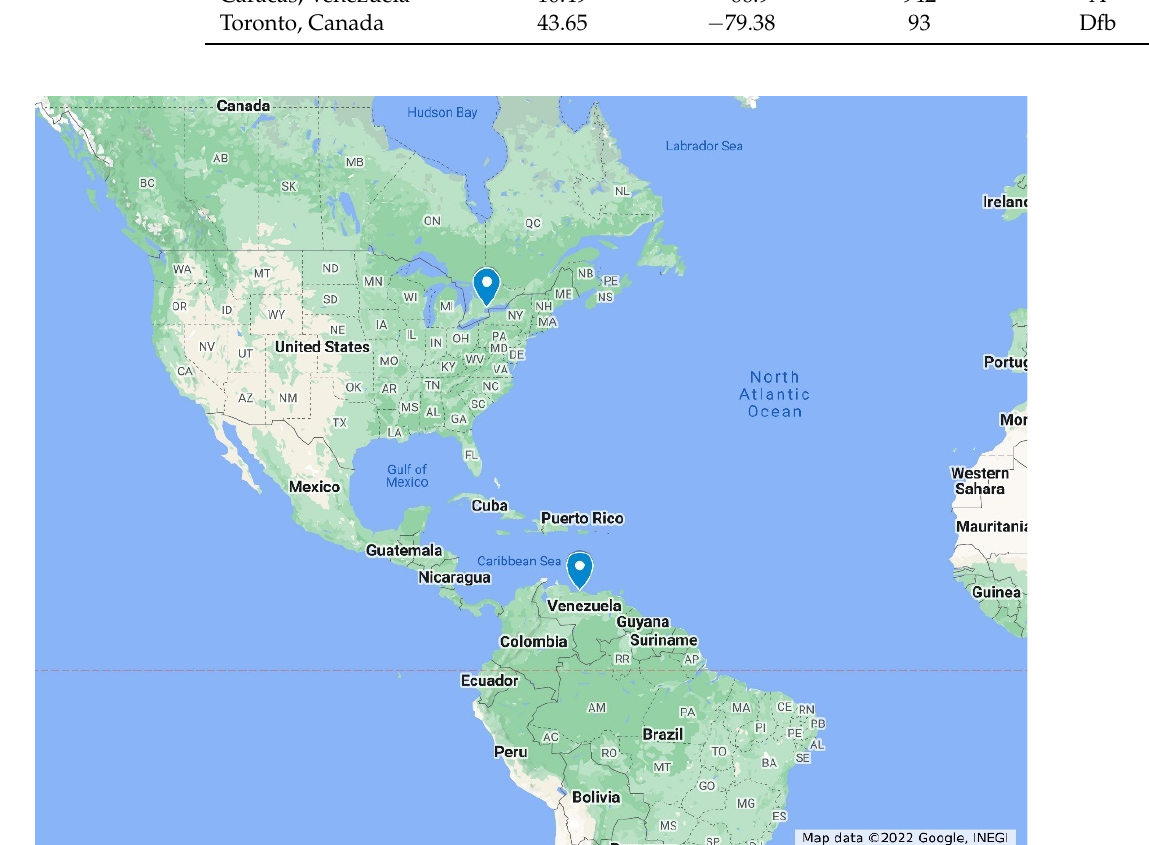
Figure 6. Toronto and Caracas locations on a map.